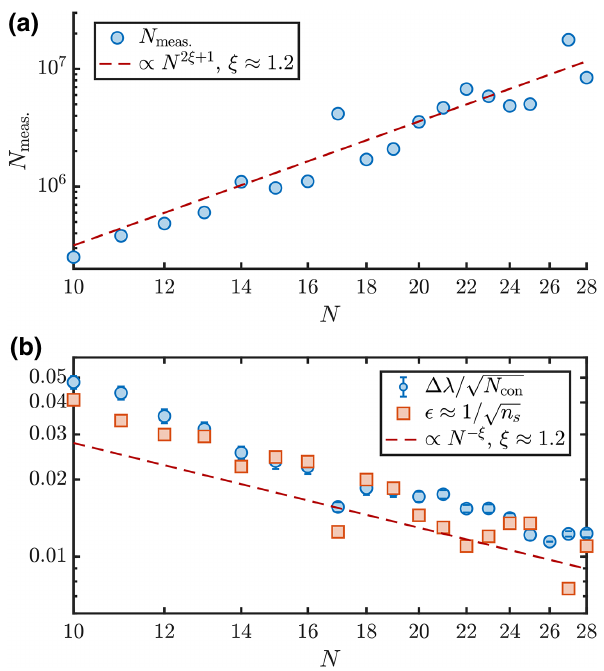
FIG. 10. Finite-size scaling of the measurement budget. (a) Total number N meas. of measurement shots versus system size N for learning the zeroth-order terms in a DQS of a disor- dered Heisenberg- XXZ model, to an average accuracy of (cid:8)ˆ c rec − ˆ c ex (cid:8) ≈ 0.1. The simulated data confirm the polynomial scaling of the measurement budget. (b) Spectral gap of the constraint matrix √ (blue data) and accuracy (cid:15) ≈ 1 / n s per matrix element for achieving (cid:8)ˆ c rec − ˆ c ex (cid:8) ≈ 0.1. The data are obtained using